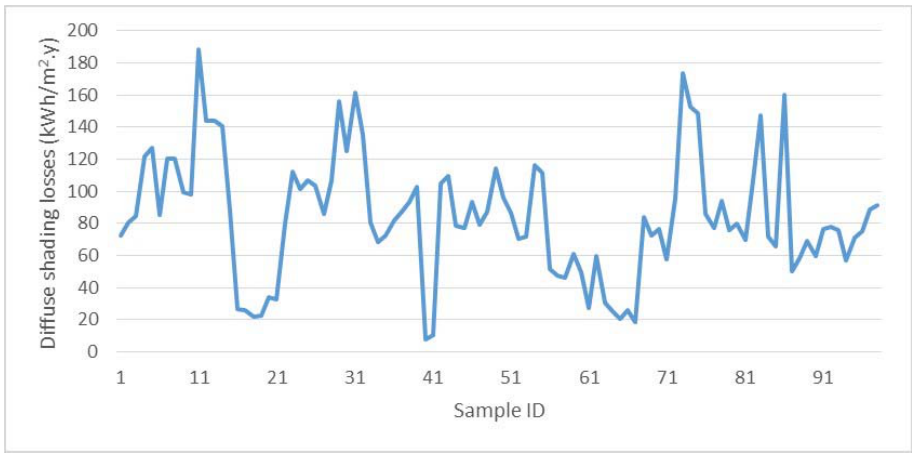
Figure 18. Diffuse shading losses assessed at the sample locations.